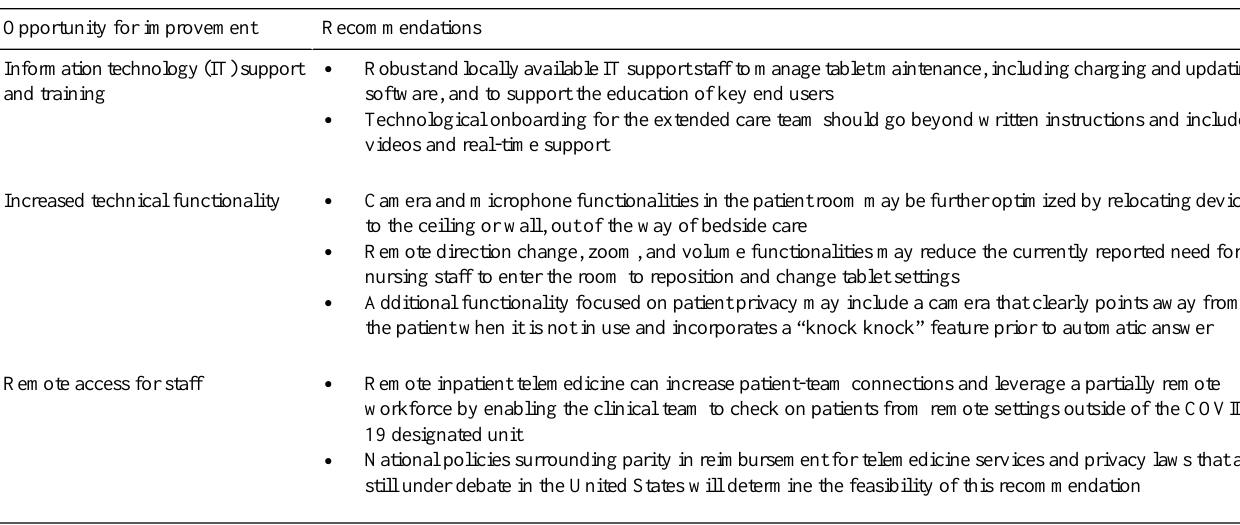
Table 2. Recommendations for improved inpatient telemedicine